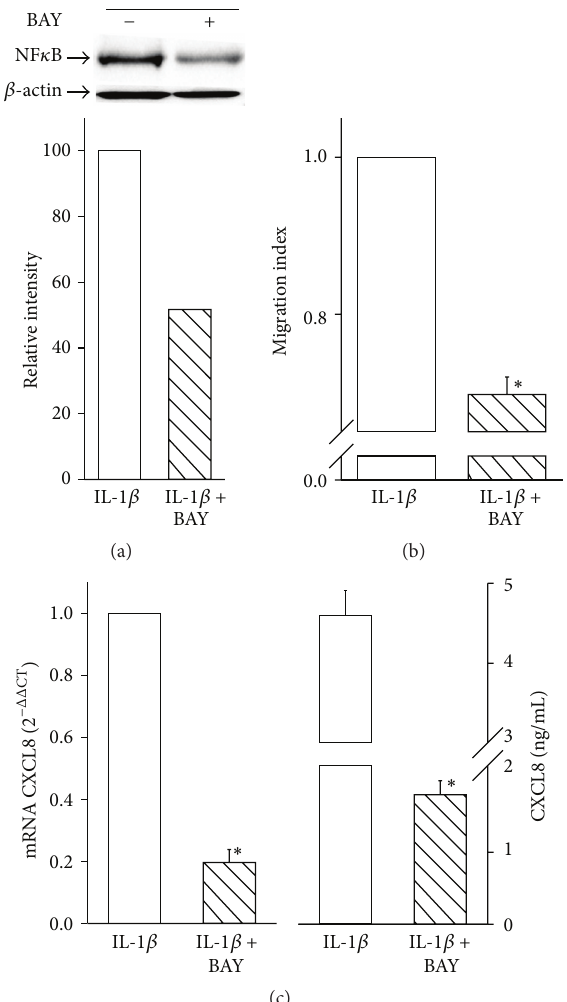
Figure4:RoleofNF 𝜅 BinIL-1 𝛽 -inducedhypoxiccellmigration.Dataareshownasmeans ± SEM. ∗ 𝑃 < 0.05 ,statisticallysignificantdifference between IL-1 𝛽 -treated hypoxic cells in the presence of BAY 11-7082 (IL-1 𝛽 + BAY) and IL-1 𝛽 -treated hypoxic cells in the absence of BAY 11- 7082 (IL-1 𝛽 ). (a) Protein expression of NF 𝜅 B was determined by Western blot analysis and a representative blot from three independent experiments is shown. Quantification of NF 𝜅 B protein expression was achieved by chemiluminescence ( 𝑛 = 3 ). (b) The migration index was calculated as a fold change of relative fluorescence of cells migrating into the lower chamber normalized to that of the untreated samples (IL-1 𝛽 ) ( 𝑛 = 3 ). (c) CXCL8 mRNA and protein expression were analyzed by qRT-PCR and ELISA ( 𝑛 = 3